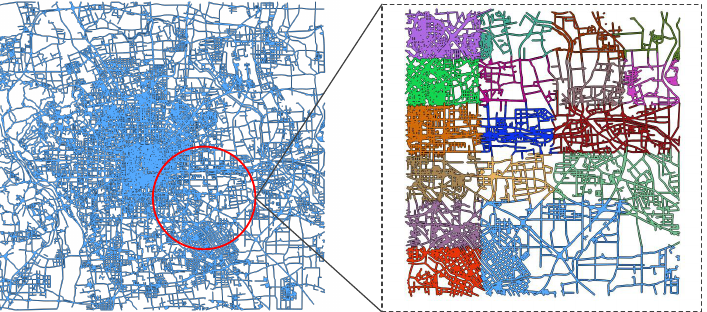
Figure 6. Buffer result and partial data splitting